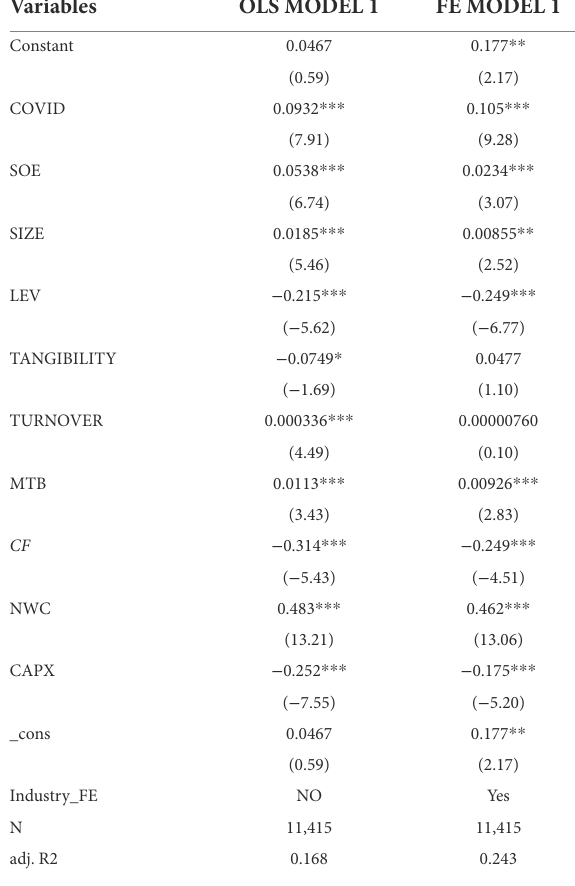
TABLE 4 The impact of COVID-19 on corporate cash